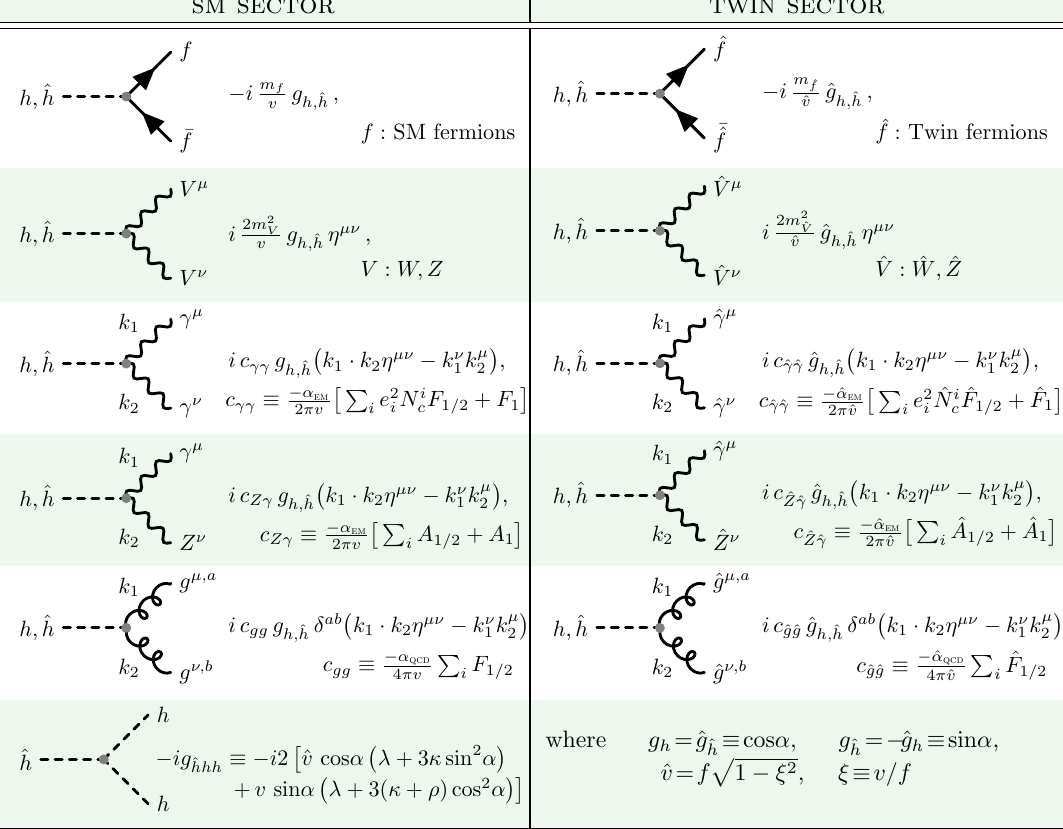
, F 1 , A F and A W are given below 1 = 2 , ^ F 1 , ^ A F and ^ A W has similar form as the 1 = 2